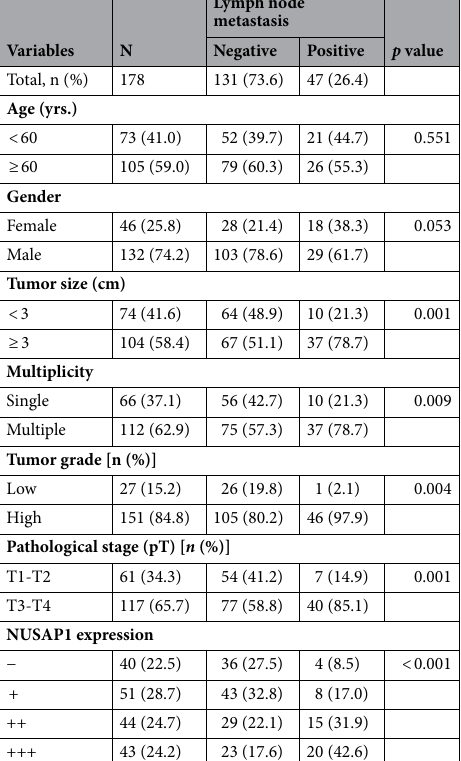
Table 4. Analysis of factors influencing lymph node metastasis in urothelial carcinoma of the